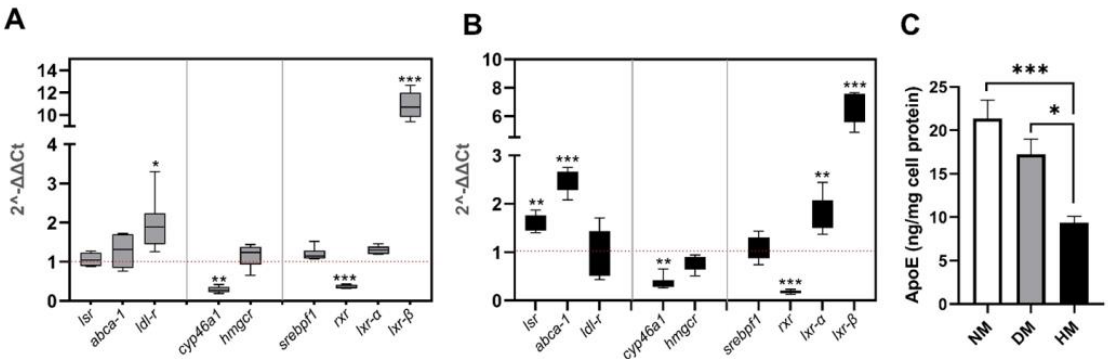
Figure 3. Effect of lipoprotein-depleted or high lipoprotein containing media on expression of lsr , genes related to cholesterol homeostasis, and ApoE levels in astrocytes. Murine astrocytes expressing human ApoE3 were incubated in the presence of normal growth media (NM), lipoprotein-depleted media (DM), or high lipoprotein containing media (HM). After 5 days incubation at 37 ◦ C, cells and media were removed and stored for RT-qPCR of target genes, and determination of human ApoE in media by ELISA. Results of qPCR analysis of target gene levels are shown in cells incubated with DM ( A ) or HM ( B ). ( C ) Human ApoE levels in the cell media expressed as ng ApoE secreted in the media per mg cell protein. Results are shown as mean ± SEM ( n = 6 per group). Statistical differences are shown as * p < 0.05, ** p < 0.01, *** p < 0.001 (for ( A , B ), as compared to control cells in NM; for ( C ), as indicated).